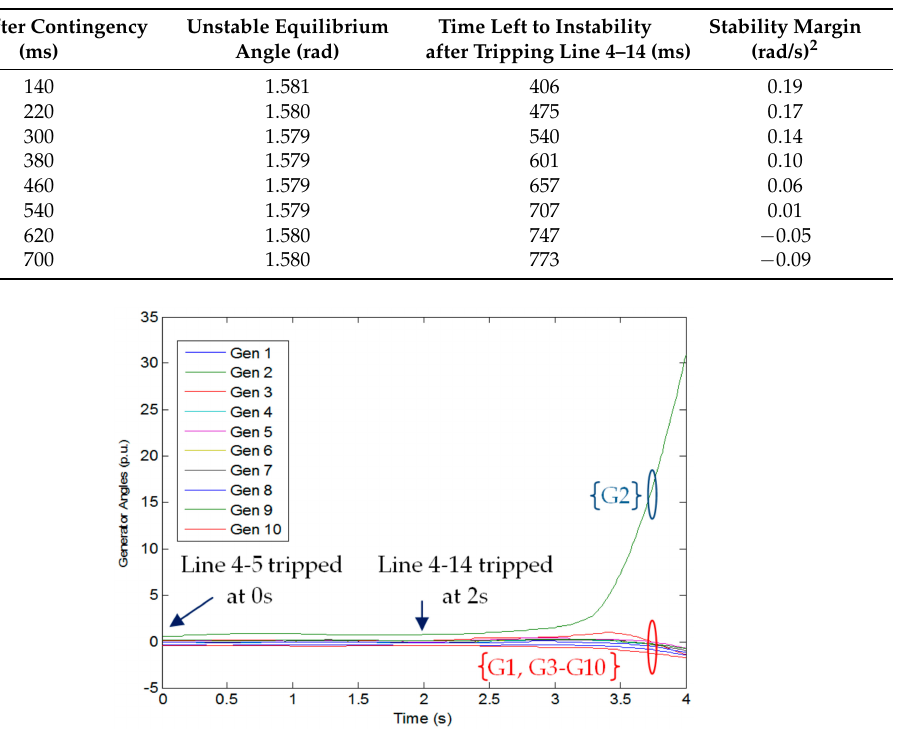
Figure 6. Transiently unstable case after Line 4–5 and 4–14 were